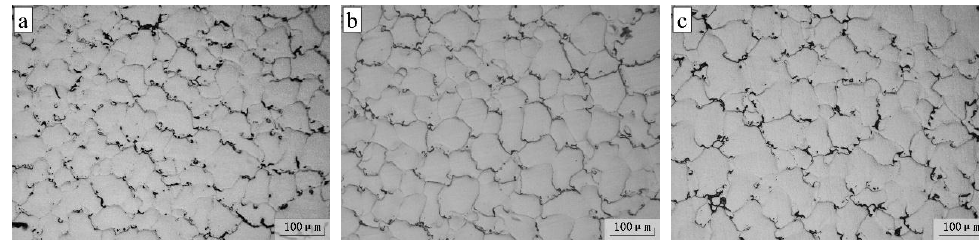
Figure 6. Microstructures of as-cast ZK60 alloy treated by variable-frequency ultrasonic vibration at ( a ) center; ( b ) 1/2R; ( c ) edge position of billet.